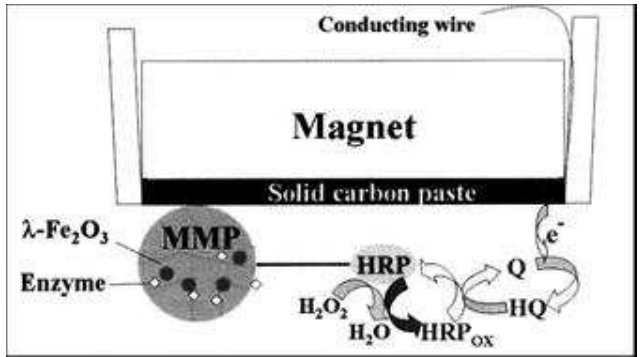
Figure 17. An enzymatic biosensor based on magnetic nanoporous silica microparticles (MMPs) where oxidation of hydroquinone (HQ) to quinone by the enzyme horseradish peroxidase (HRP) in presence of hydrogen peroxide and subsequent electroreduction of quinone (Q) is